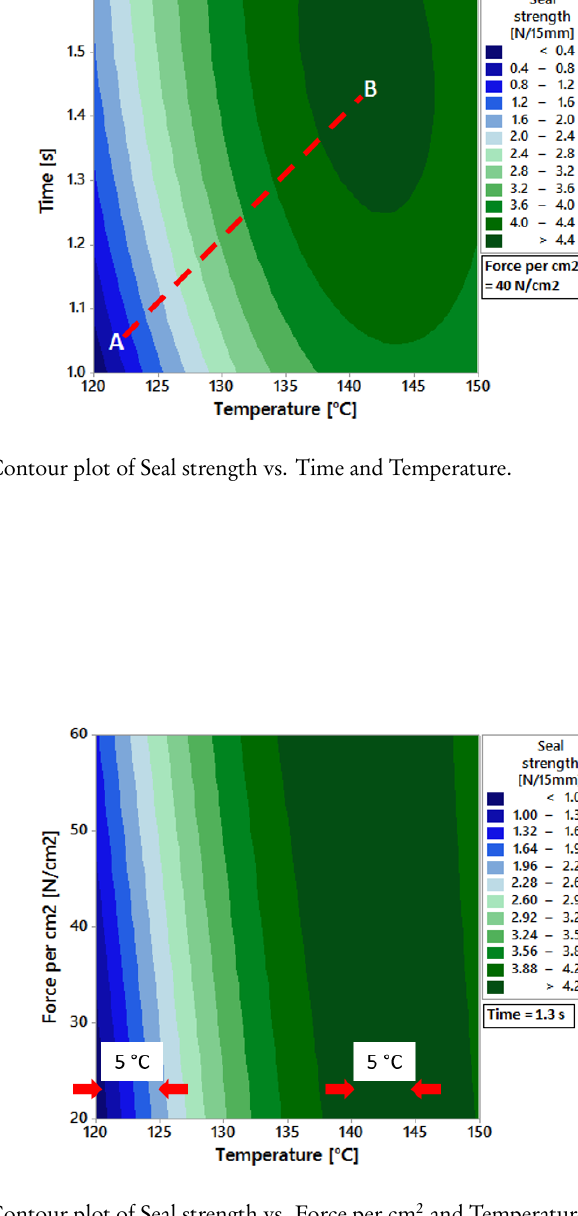
Figure 9 – Contour plot of Seal strength vs. Force per cm 2 and